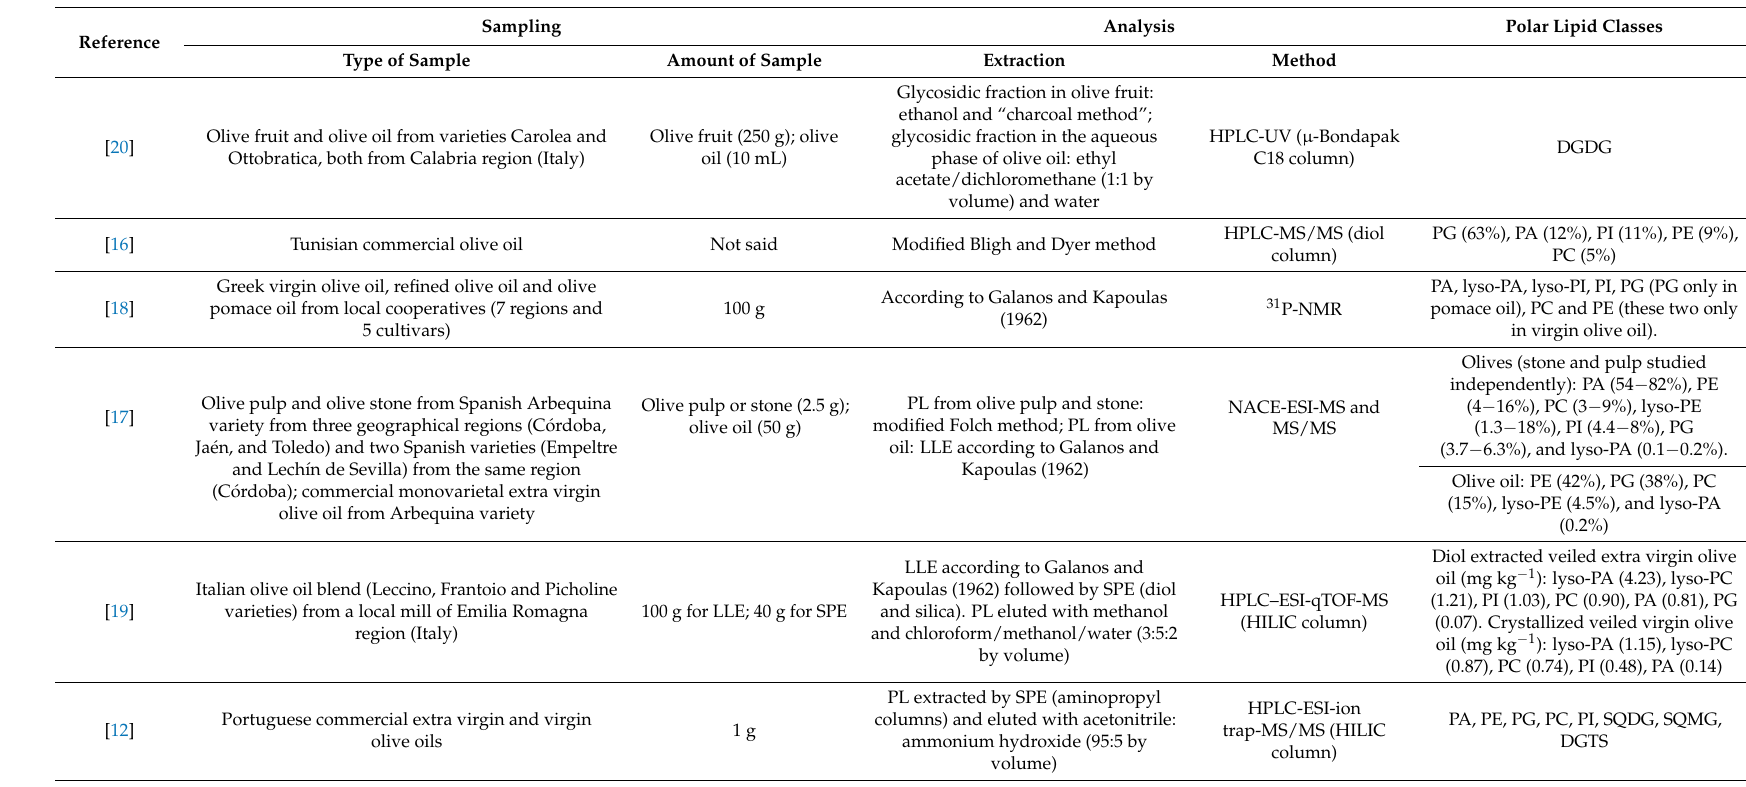
Legend: DGDG, digalactosyldiacylglycerol; DGTS, diacylglyceryl-N,N,N-trimethylhomoserine; HILIC, hydrophilic interaction liquid chromatography; HILIC-ESI-MS/MS, hydrophilic interaction liquid chromatography coupled to electrospray ionization tandem mass spectrometry; HPLC, high-performance liquid chromatography; HPLC-ESI-qTOF-MS, high-performance liquid chromatography coupled to electrospray ionization-quadrupole time-of-flight mass spectrometry; HPLC-UV, high-performance liquid chromatography with ultraviolet detector; HPLC-MS/MS, high-performance liquid-chromatography coupled to tandem mass spectrometry; LLE, liquid/liquid extraction; MS/MS, tandem mass spectrometry; NACE-ESI-MS, non-aqueous capillary electrophoresis coupled to electrospray ionization mass spectrometry; NMR, nuclear magnetic resonance; PA, phosphatidic acid; PC, phosphatidylcholine; PE, phosphatidylethanolamine; PG, phosphatidylglycerol; PI, phosphatidylinositol; PL, polar lipid; SPE, solid-phase extraction; SQDG, sulfoquinovosyldiacylglycerol; SQMG,